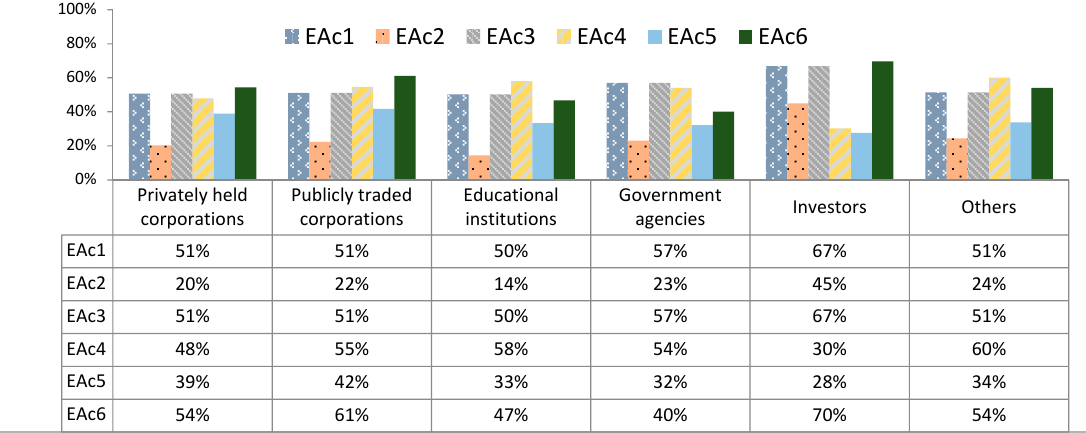
Figure 3. Percent maximum points (PMP) based on building ownership.